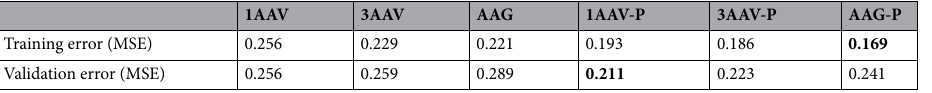
Table 1. Comparison of six encoding methods for predicting blockade signals. Significant values are in